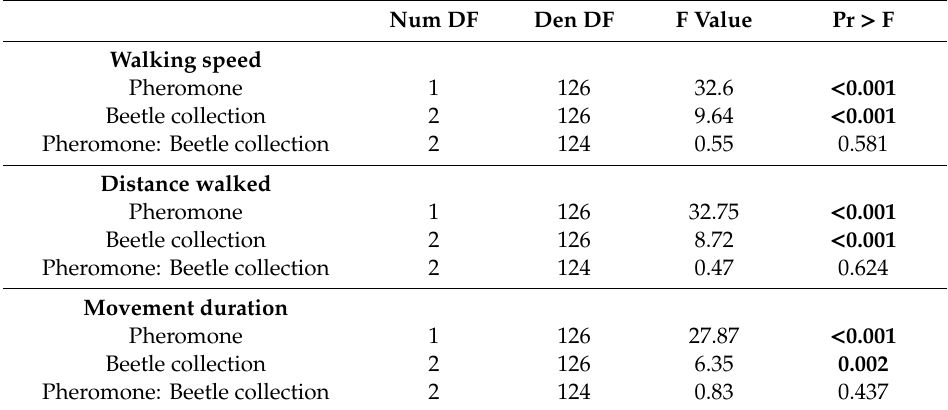
Table 2. Statistical model output for the e ff ect of pheromone on the walking speed, distance walked, and proportion of time moving for male Agriotes obscurus collected in March, April, and May. Experiment day is included as a random e ff ect.